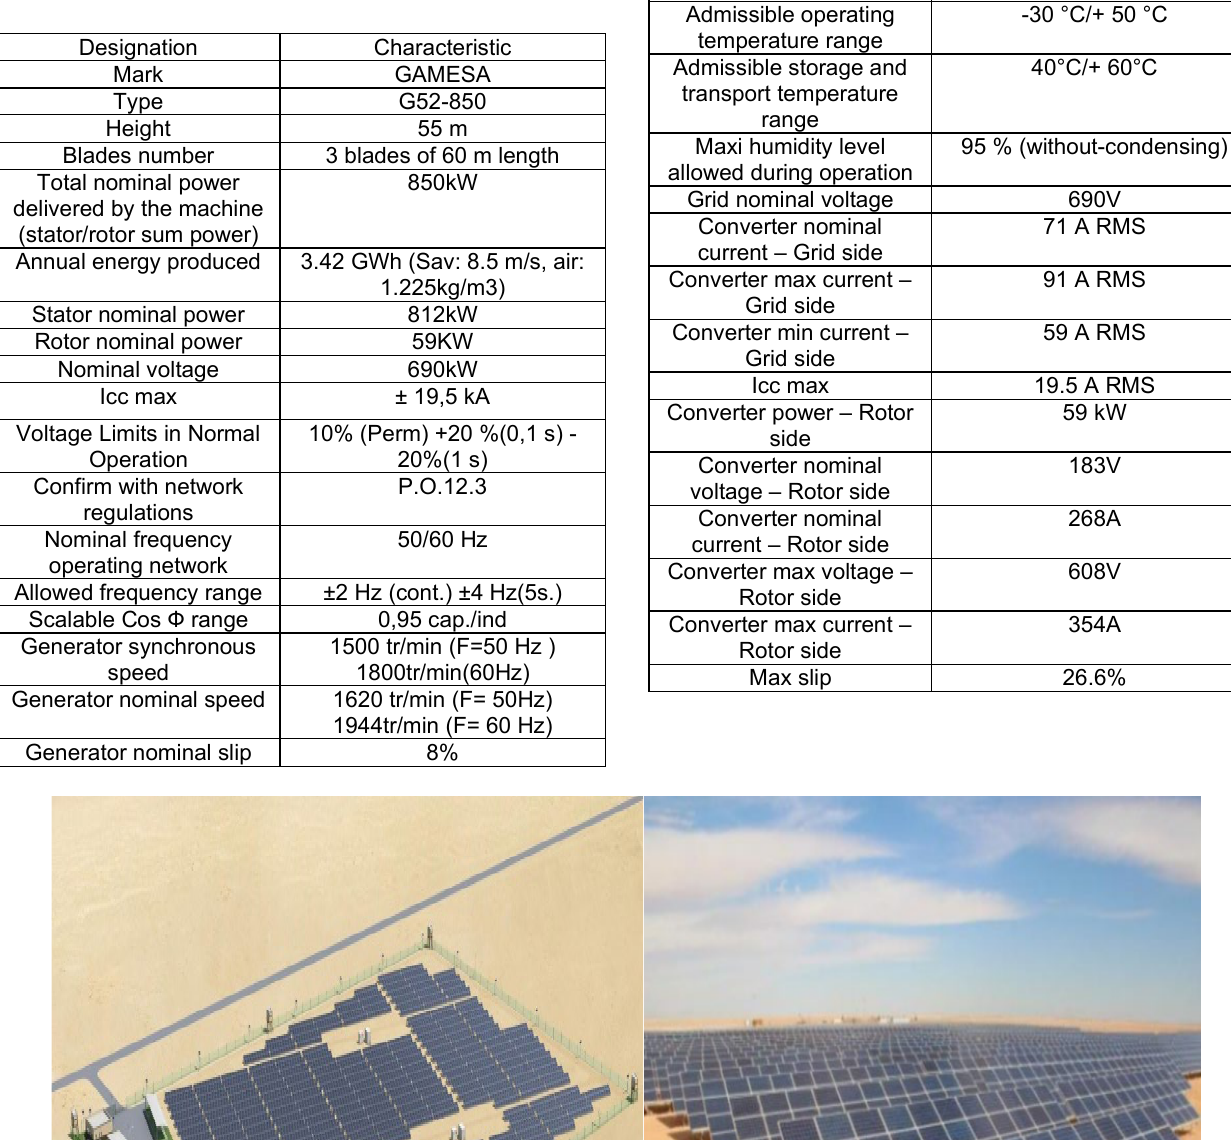
Table 12: DFIG and converter technical specifications